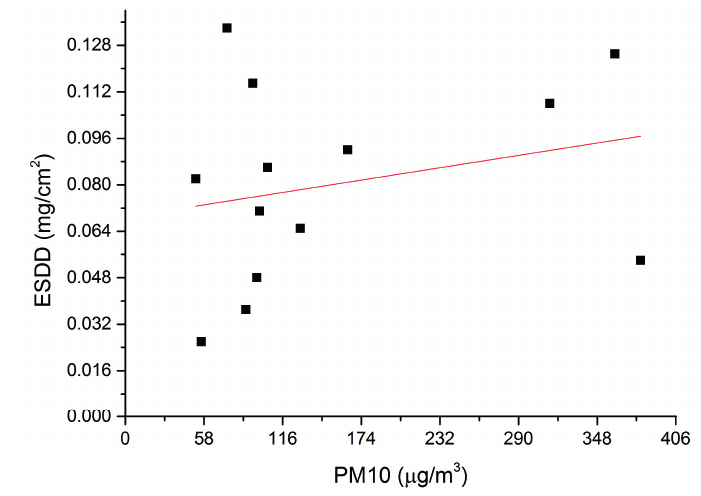
Figure 9. Correlation between the mean ESDD and instantaneous PM 10 , where the red line is the linear regression equation.